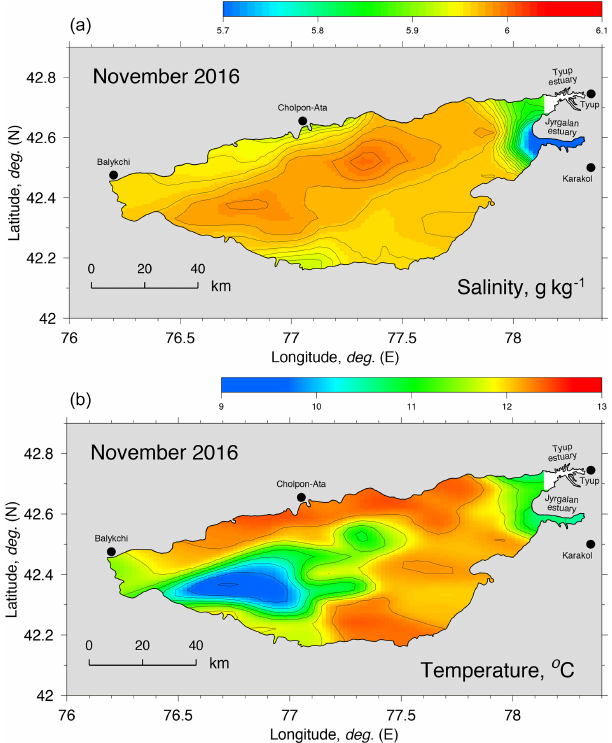
Figure 3. (a) Salinity and (b) temperature distributions at the lake surface in November 2016, based on pump-through CTD measure-